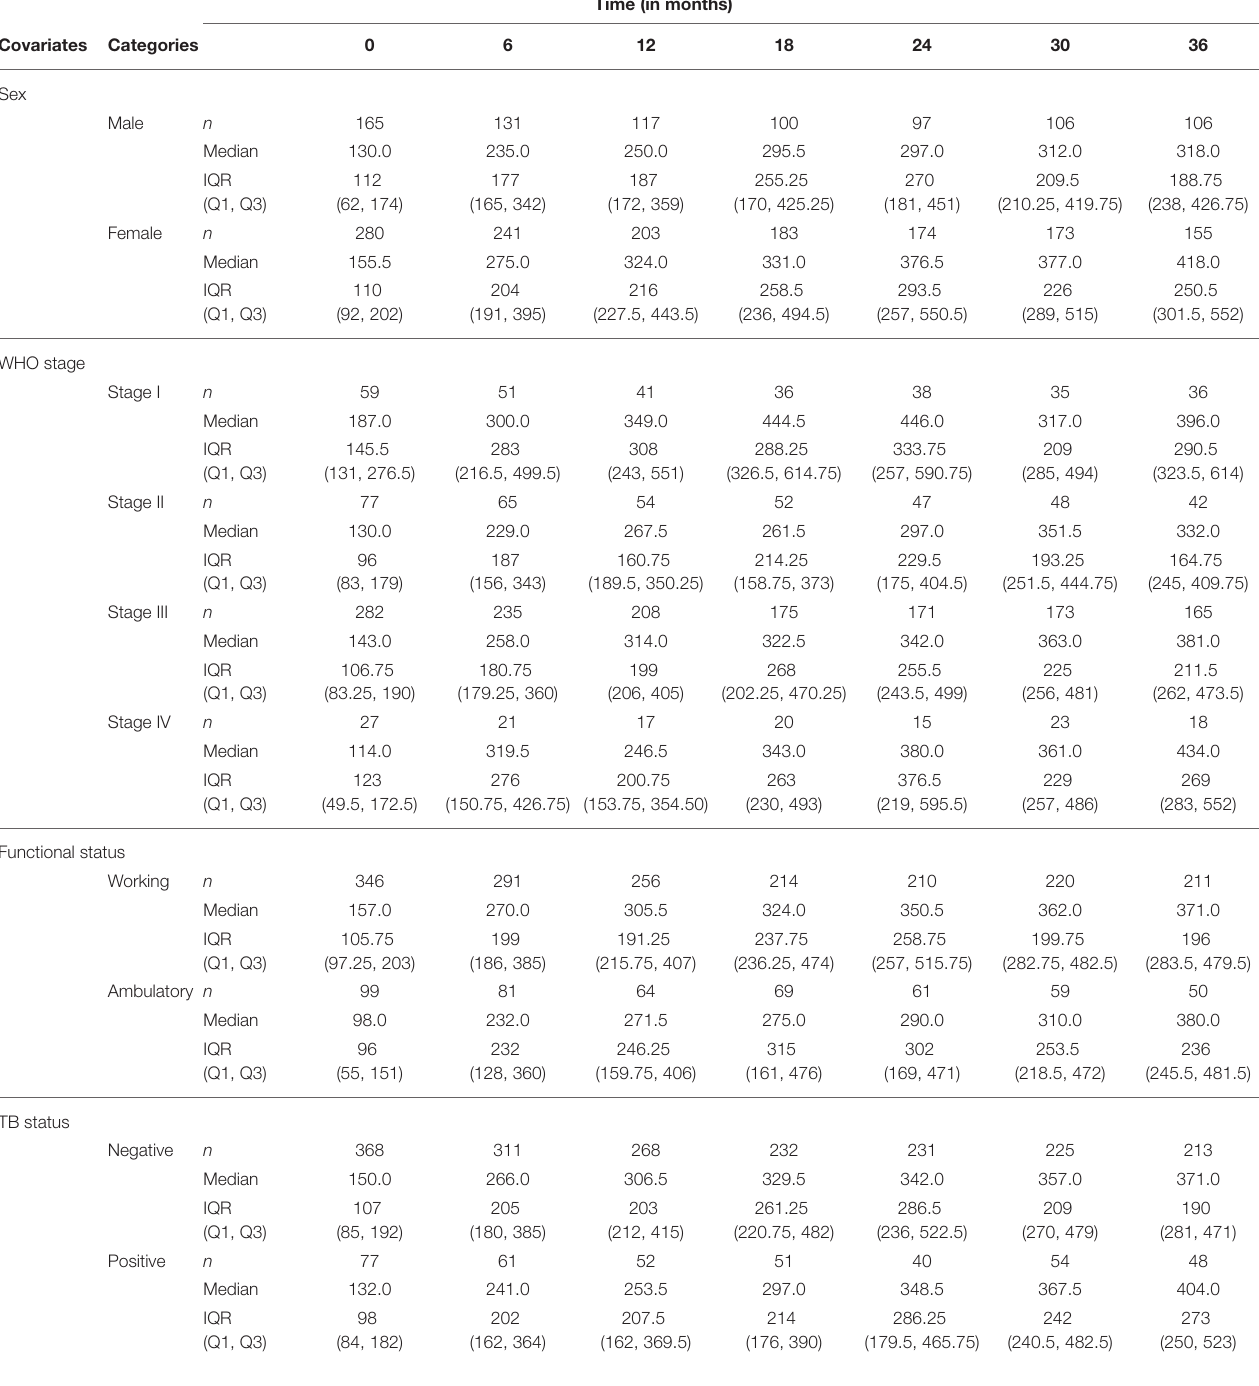
TABLE 3 | Summary of CD4 + cell count progression for some categorical